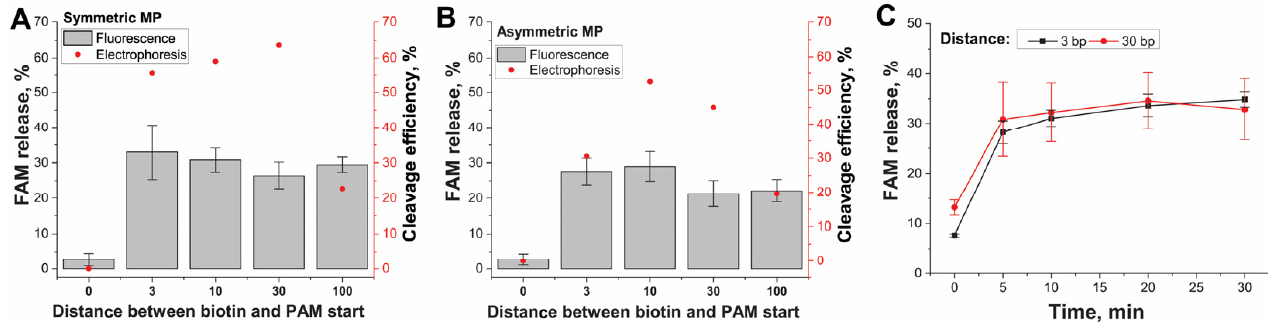
Figure 5. Cis-cleavage of DNA (IGS(II))–streptavidin–MP conjugates differing in the ds-adaptor length between PAM and the MP surface. ( A ) SMPs conjugates, ( B ) AMPs conjugates. Fluorescence values are depicted as gray bars. Efficiency values of cleavage according to gel electrophoresis are depicted as red dots. ( C ) Kinetic of the cis-cleavage for IGS(II)-3 and IGS(II)-30 bound to SMPs.